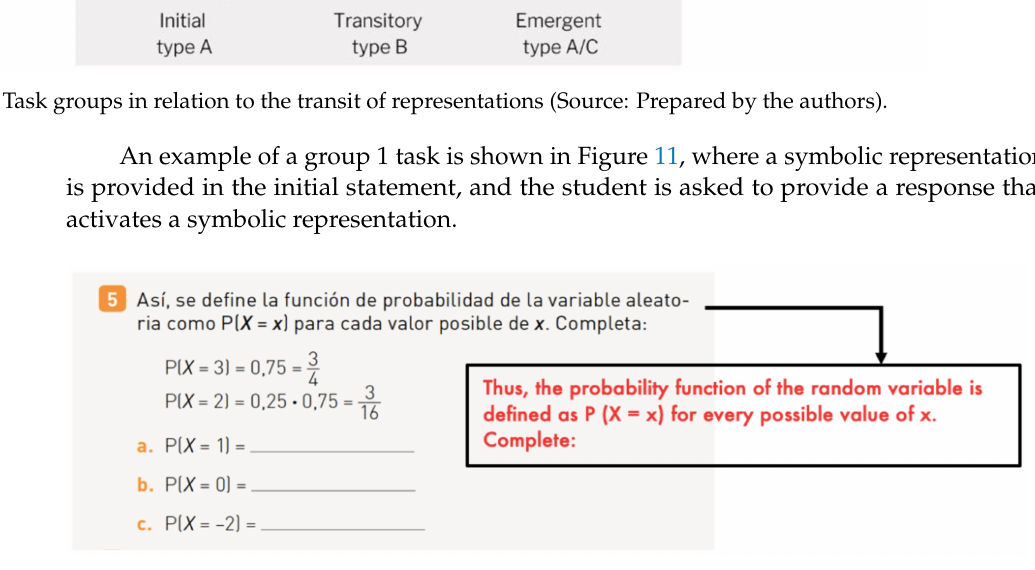
Figure 11. Example of group 1 task: symbolic–symbolic (Adapted from [34] (p. 279)).